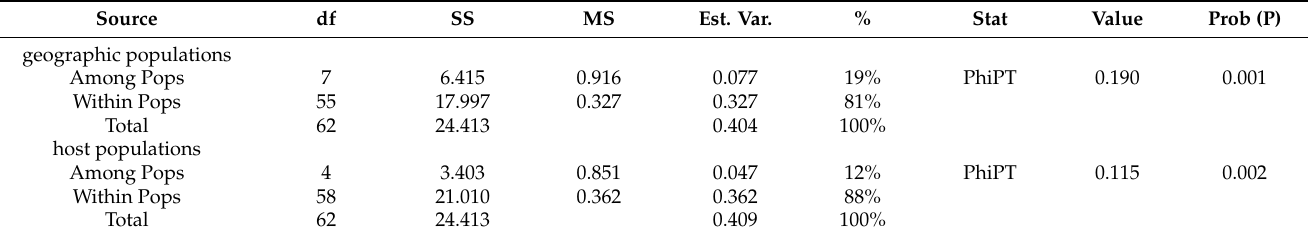
Table 2. Summary of AMOVA tests within and among the geographic populations and host popula- tions of Colletotrichum gloeosporioides from Citrus in